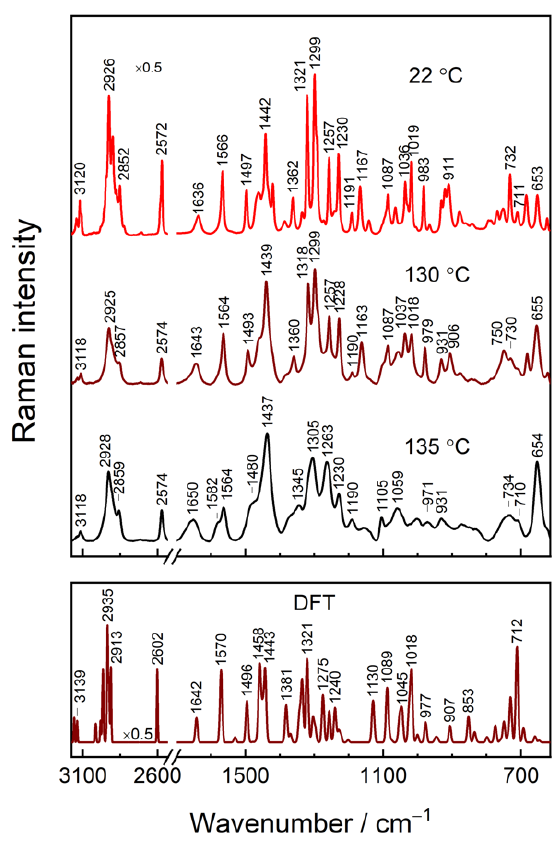
Figure 4. Temperature-dependent Raman spectra of solid IMHA at 22, 130, and 135 °C (upper panel) and DFT spectrum of IMHA (bottom panel). The intensity of the 2530–3175 cm − 1 region is scaled by 0.5.